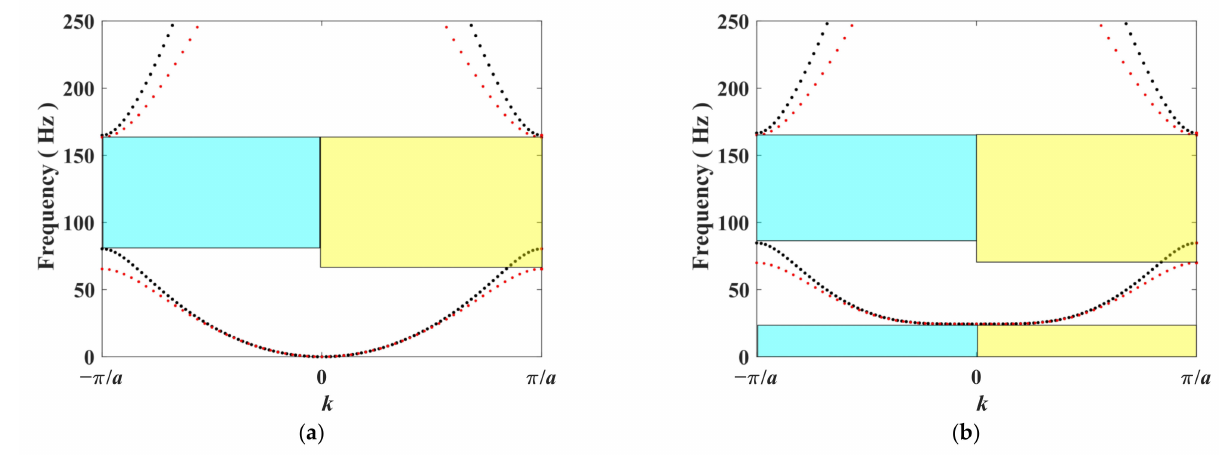
Figure 3. Dispersion curve: ( a ) c = 0 N/m 3 ; ( b ) c = 3 × 10 6 N/m 3 .